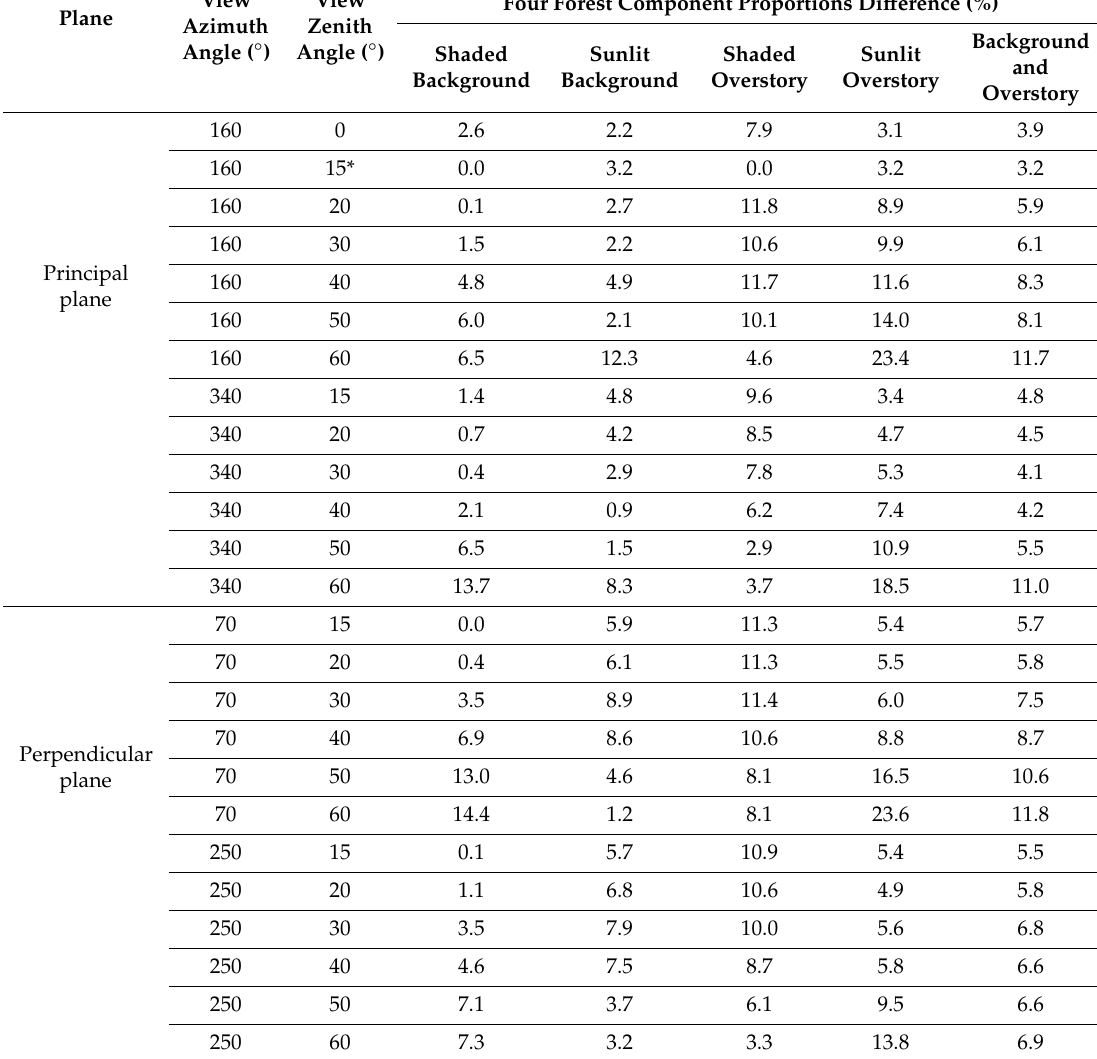
Table 6. The comparison of four forest component proportions resulting from WPA-P2 and WPA-P2E plots.